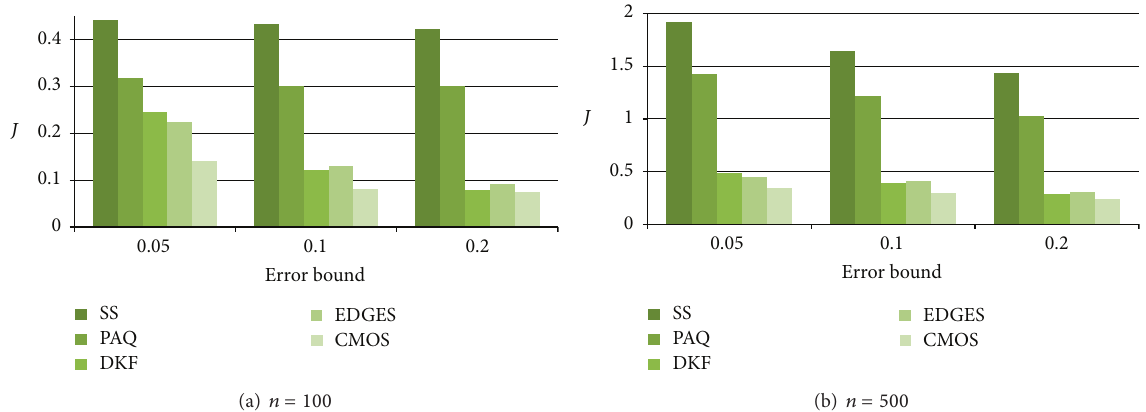
Figure 5: Average energy consumption on Wave data.